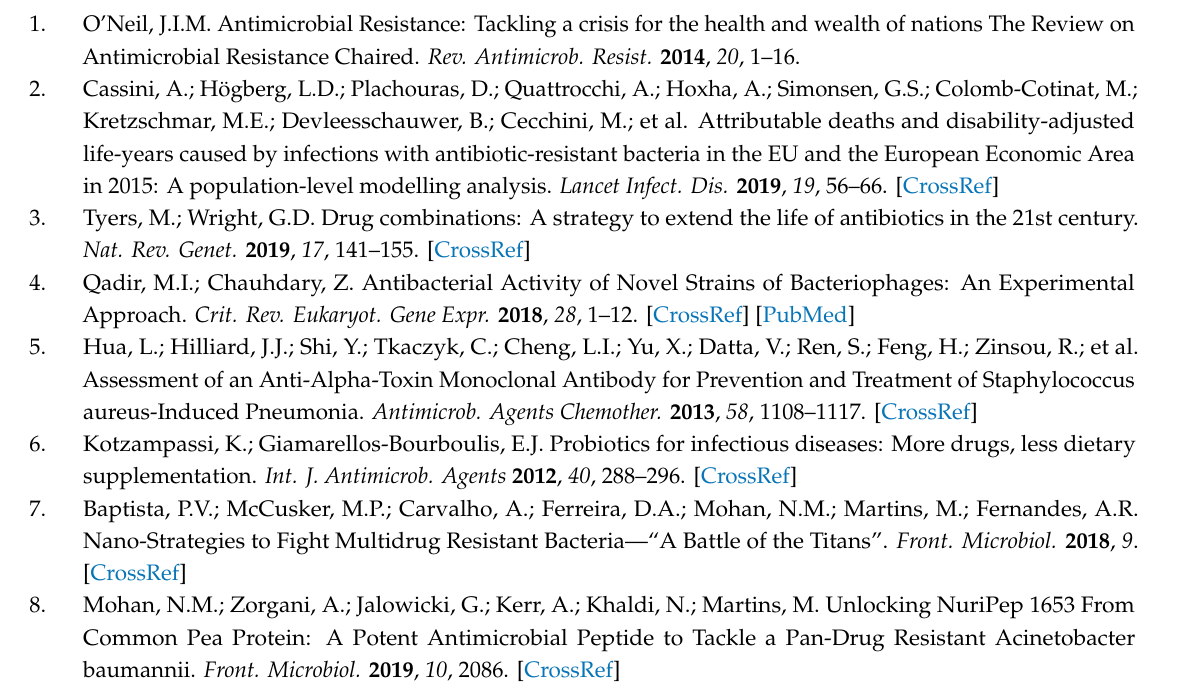
Figure S1: Determination of the equilibrium concentration of ethidium bromide (EtBr) in S. aureus (A), L. monocytogenes (B), E. coli (C), S. Typhimurium (D), A. baumannii (E), K. pneumoniae (F) and P. aeruginosa (G). Table S1: Antibacterial activity of metallic compounds against Gram -positive and -negative